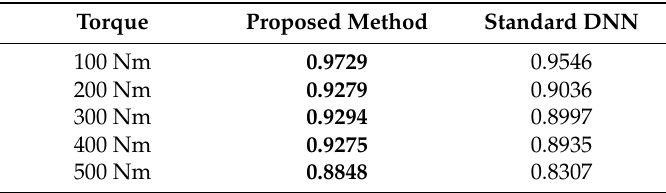
Table 4. Averaged accuracy under 5